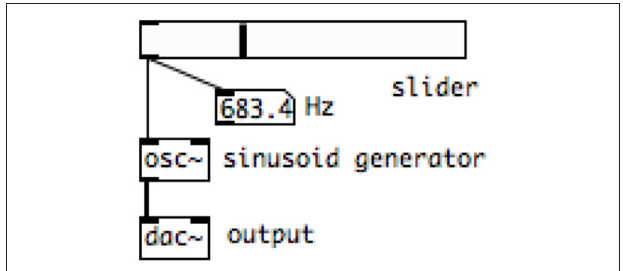
FIGURE 4 | Audio signal graph expressed in